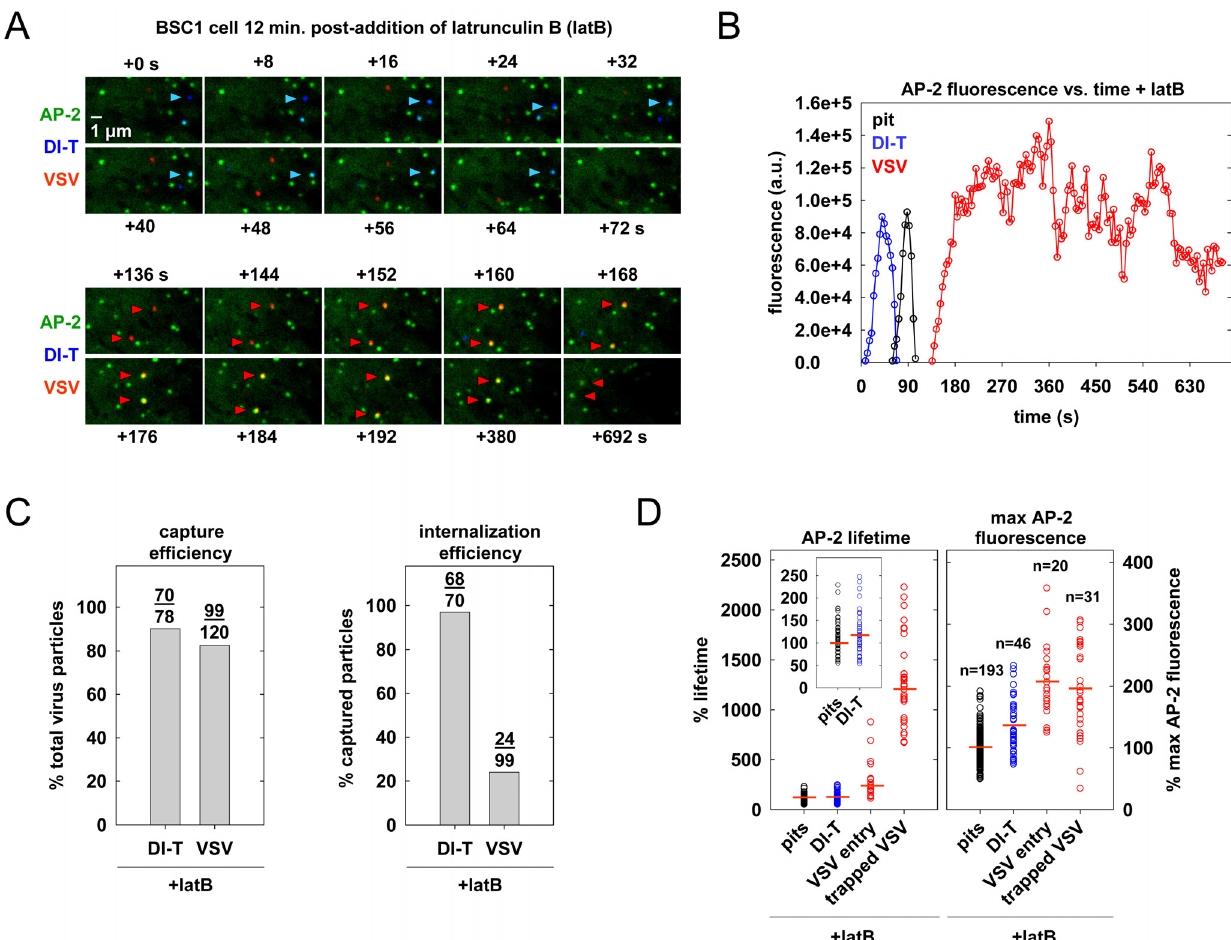
Figure 6. Actin polymerization is not required for DI-T internalization. (A) The endocytic fate of virus particles after inhibition of actin polymerization. BSC1 cells stably expressing s 2-eGFP (green) were treated with 6.3 m M latB for 12 min. and inoculated with DI-T and VSV particles in the continued presence of latB. Time-lapse images of a single cell were acquired at 4 s intervals for 692 s, and an 8.8 6 5.0 m m 2 area of the cell surface is shown. The upper panels show the complete internalization of a DI-T particle (blue, blue arrowheads), where + 0 s indicates the first frame of the time-lapse series. The lower panels show the subsequent capture but failed internalization of 2 VSV (red, red arrowheads) particles on the same area of cell membrane (time scale continued from above) (Video S8). (B) AP-2 fluorescence intensity for the events shown in A. Note that the adaptor fluorescence associated with the DI-T particle (blue) and a conventional coated pit (black) that formed within the same membrane area peak and disappear normally, while the adaptor signal associated with the upper-most VSV particle (red) does not, signifying failed internalization. (C) Effect of latB on the efficiency of virus capture and internalization. BSC1 cells stably expressing s 2-eGFP were treated and imaged as described in A. Left, the percentage of virus particles that were captured by a clathrin structure after attachment. Right, the percentage of captured virus particles that were successfully internalized within 300 s of capture (see D. for details). Cumulative data are from 5 cells. (D) Effect of latB on the lifetime and peak fluorescence intensity of AP-2 in clathrin structures. Data were acquired as described in A. and displayed as in the legend of Figure 3C. Left, relative lifetime of AP-2 in structures that lack (pits, black) or capture a virus particle. Inset shows a rescaled distribution of the pit and DI-T internalization events. Right, maximum fluorescence intensity of AP-2 in the events at left. Data are from 4 of the 5 cells analyzed in C, as thermal drift during imaging prevented accurate fluorescence intensity measurements in one cell. The number of events in each category is shown above the corresponding plots at right. DI-T (blue) data consists only of productive internalization events. VSV events are categorized as productive internalizations (VSV entry, red) or non-productive captures (trapped VSV, red). A non-productive capture is defined as a stable colocalization between a spot of AP-2 and a VSV particle that began at least 300 s before the last captured image and did not result in virus uptake before cessation of imaging. The 300 s cutoff was chosen because a majority (22/24) of productive internalizations occurred within 300 s of capture. Captures in which the final image frame was acquired before 300 s elapsed were excluded from the analysis, as the eventual endocytic fate of the particle cannot be predicted.